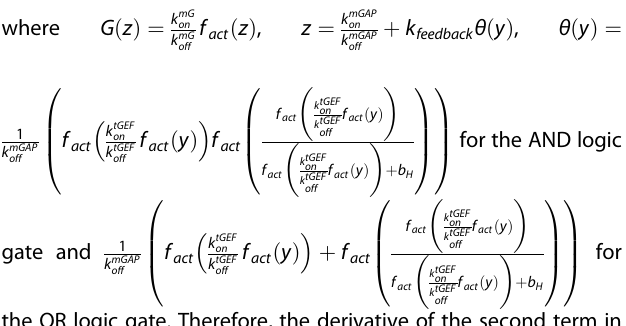
. So, k AND feedback h 1 ð mG (cid:1) ss Þ h 2 ð mG (cid:1) ss Þ